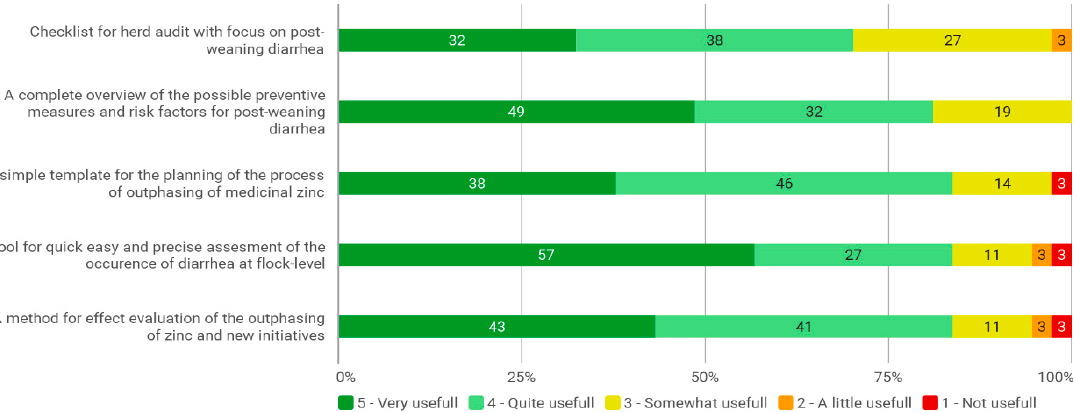
Figure 3. Danish veterinarians scoring the usefulness of five different tools for herd health advice regarding the out-phasing of medicinal zinc.